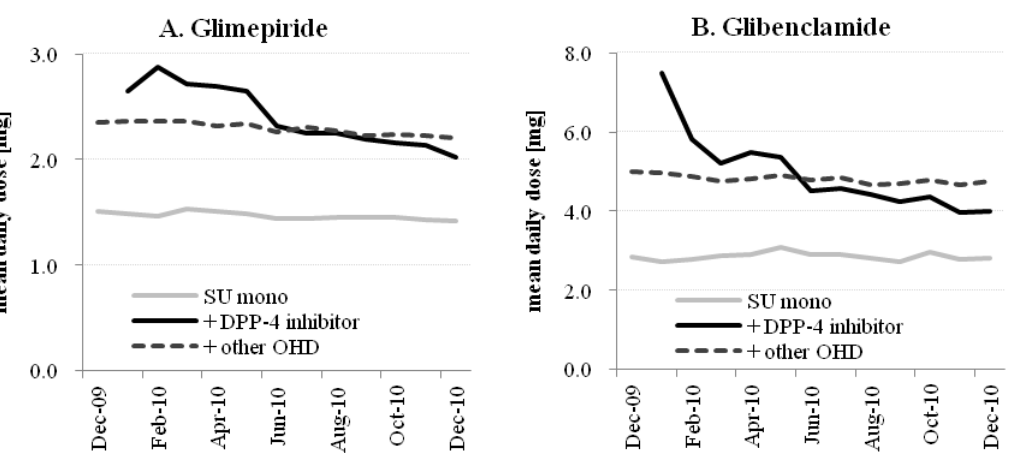
Figure 2. Chronological trend in SU mean daily dose with or without same-day DPP-4 inhibitor and the other oral hypoglycemic drugs (OHD). The mean daily dose of glimepiride ( A ) glibenclamide; ( B ) gliclazide; ( C ) was calculated for every 10 days. Gray lines indicate the SU monotherapy, black lines indicate the SU with same-day DPP-4 inhibitor, and dotted lines indicate SU with same-day OHDs but not with DPP-4